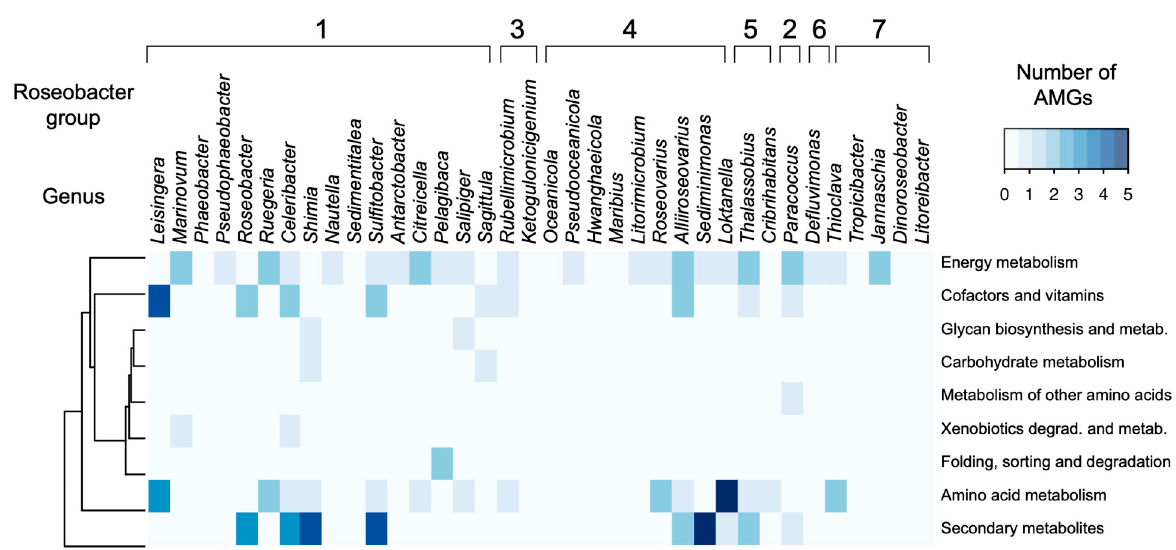
Figure 3. Roseobacter prophages encode auxiliary metabolic genes involved with secondary and amino acid metabolism. AMG distribution across the 36 roseobacter genera encoding prophages. Roseobacter genera are ordered and grouped according to their phylogenetic clade in Simon et al. 2017 [59].